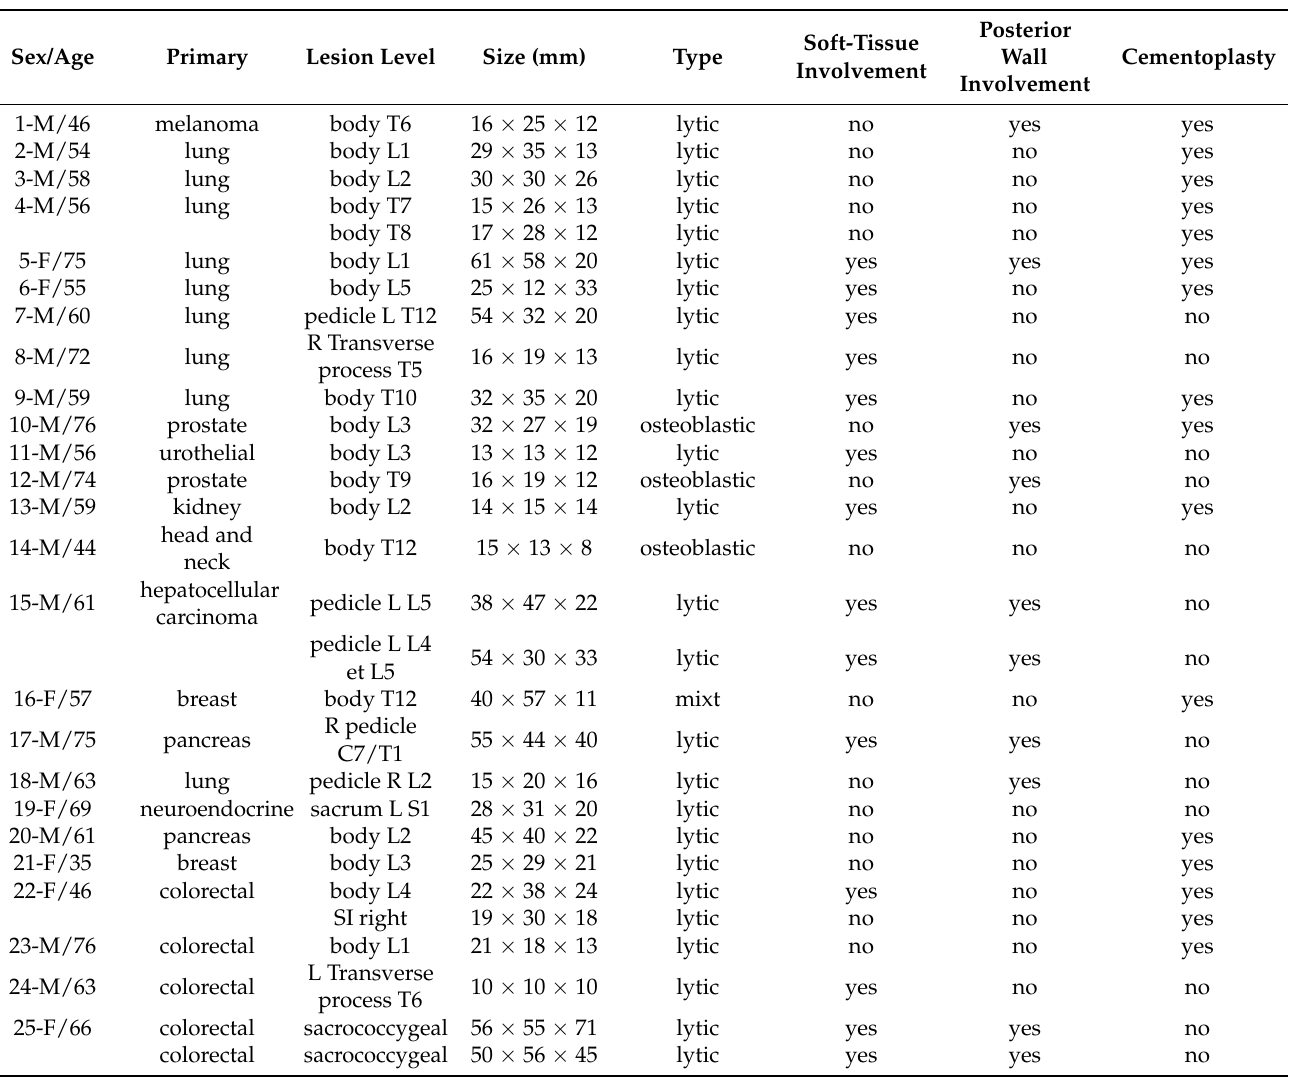
Table 1. Patient and lesion